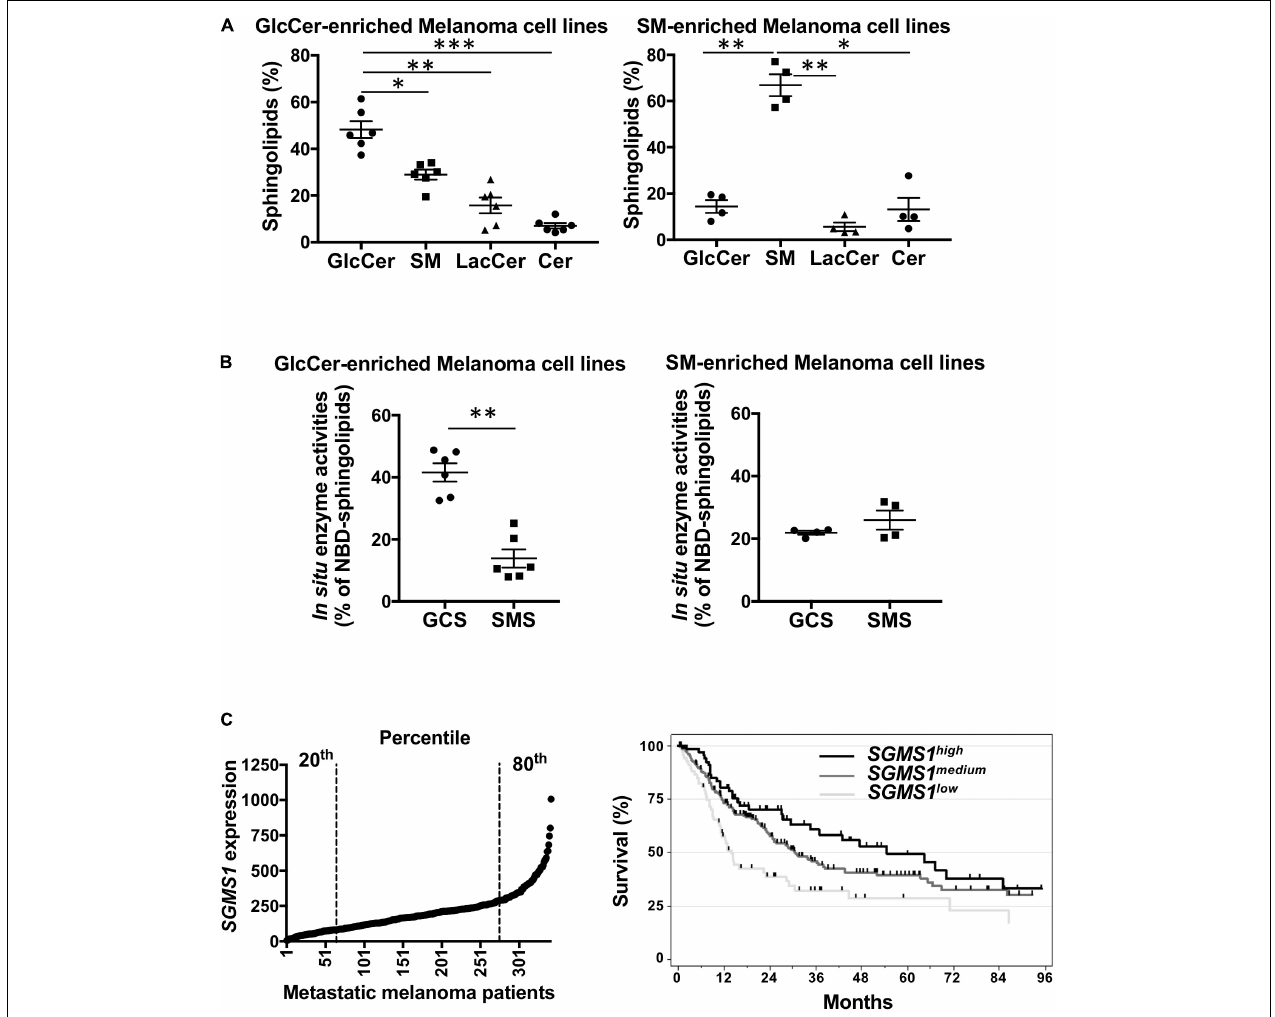
FIGURE 2 | Sphingomyelin synthase 1 downregulation is associated with a worse prognosis in advanced melanoma patients. (A , B) A set of melanoma cell lines ( n = 10) was analyzed for SLs by mass spectrometry (A) and GCS and SMS enzyme activities (B) . Data from one experiment representative of three independent experiments are means ± SEM. (C) SGMS1 expression in melanoma samples from the TCGA melanoma cohort ( n = 342) (left panel) and overall survival of patients exhibiting low ( n = 68), medium ( n = 206), and high ( n = 68) SGMS1 expression (right panel). Cox model: SGMS1 low (Reference), SGMS1 medium : HR = 0.62 [95% CI = 0.44; 0.88] p = 0.007; SGMS1 high : HR = 0.48 [95% CI 0.31; 0.76] p = 0.002. ∗ p < 0.05, ∗∗ p < 0.01, and ∗∗∗ p <